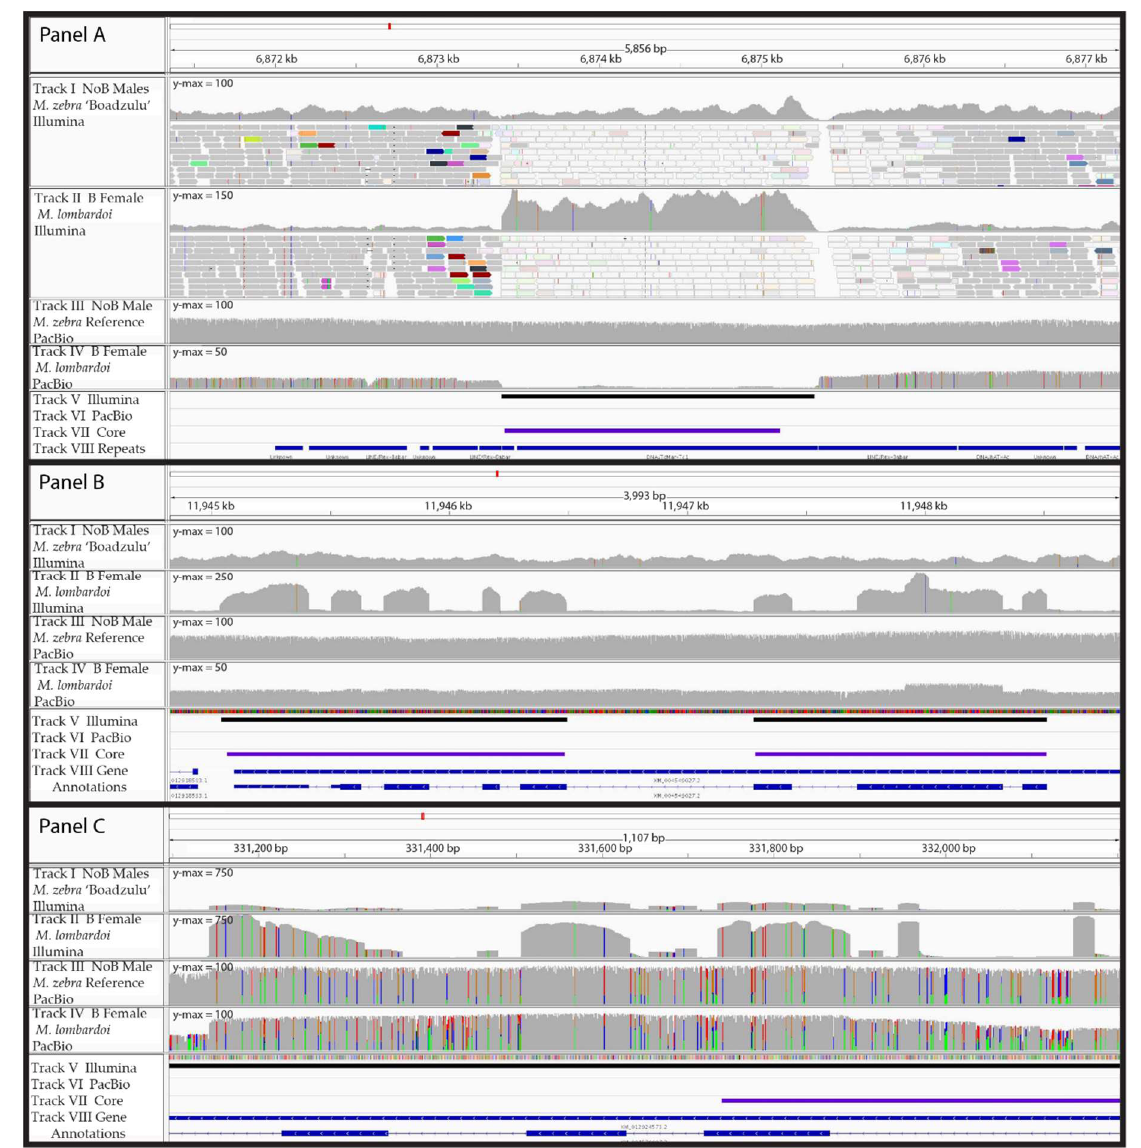
Figure 3. Comparisons of Illumina and PacBio read alignment in B blocks. Differences in the alignment of Illumina and PacBio reads affected the B block identification analysis. Panels ( A – C ) represent regions of LG20, LG22, and the unanchored scaffold 000256F_pilon_quiver, respectively. Panel ( A ) demonstrates a failure to identify a B block with PacBio data. Additionally, the localization of that block with Illumina data to a recent insertion inaccurately suggests LG20 as the A chromosome origin of this B-located sequence. Panel ( B ) demonstrates the failure of PacBio data to detect a retrogene. Panel ( C ) demonstrates a case where Illumina data suggests a retrogene, which the PacBio data reveals to be a complete gene (possessing both exons and introns). This specific example also shows increased coverage in the NoB data, suggesting the region has also experienced a duplication event within the A genome in addition to the copies present on the B chromosome. In Panels ( A – C ), tracks I and II represent the coverage of the NoB male and B female sequenced with Illumina, respectively, while tracks III and IV depict the coverage of the NoB male and B female sequenced with PacBio, respectively. In Panels ( A – C ), the B female M. lombardoi block sets for Illumina and PacBio are shown in tracks V and VI, respectively, while the core block set is shown in track VII. Tracks I and II in Panel ( A ) also show a portion of the reads aligning to that region. Reads shown in white have a map quality of 0 indicating multiple mapping to several regions. In Panel ( A ), track VIII displays the annotated repeat content of this region. In Panels ( B , C ), track VIII displays the gene annotations. Please note the y-axis maximum of the coverage plots varies to best view the variable coverage data of each plot.